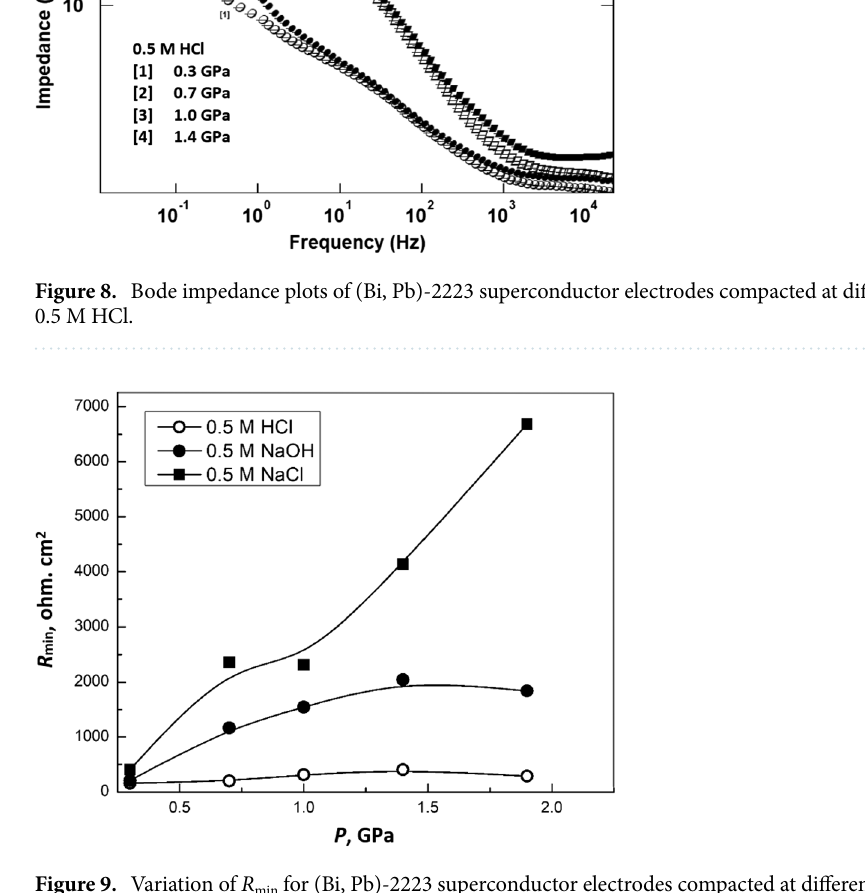
Figure 9. Variation of R min for (Bi, Pb)-2223 superconductor electrodes compacted at different pressure in 0.5 M HCl, NaOH and